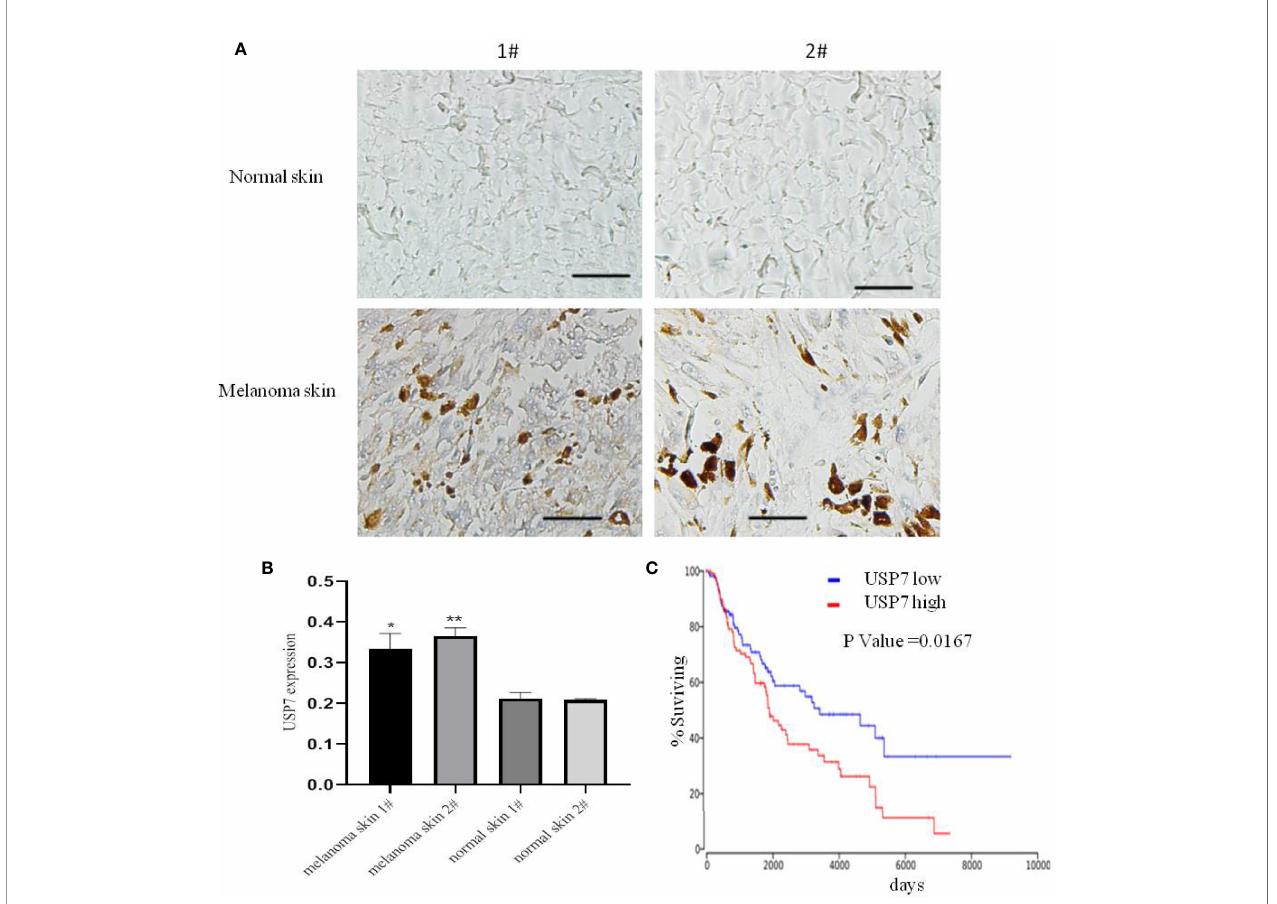
FIGURE 1 | USP7 is overexpressed in melanoma and predicts clinical outcome. (A, B) Immunohistochemical analysis of USP7 in human normal skin and melanoma tissue. The data were analyzed with ImageJ software. Scale bar, 50 m m. *p<0.05,**p<0.01. (C) Kaplan-Meier curves from patients with melanoma expressing low and high USP7 from the TCGA protein expression array